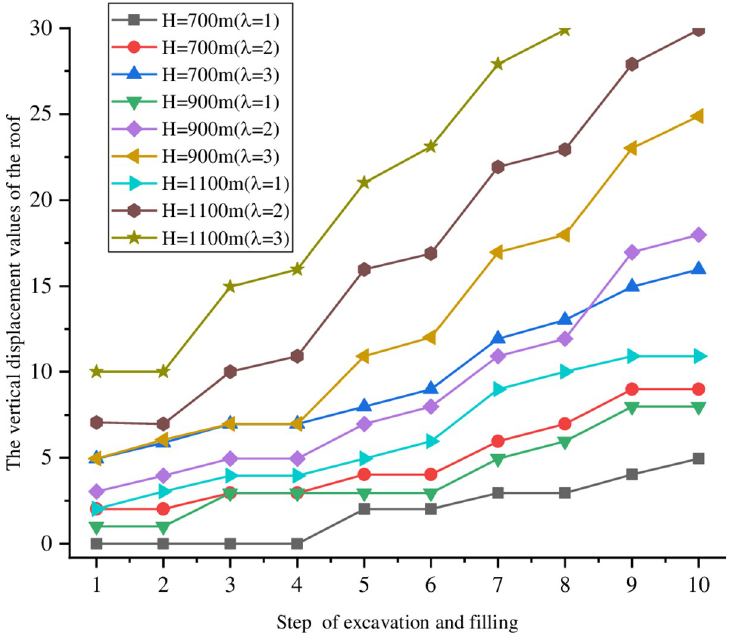
Fig 5. Vertical displacement of the monitoring points at the bottom at different